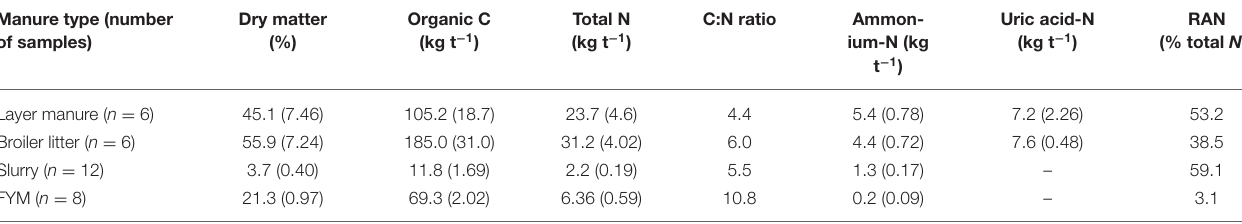
TABLE 4 | Mean manure analysis across all sites (fresh weight basis). Manure type (number of samples)